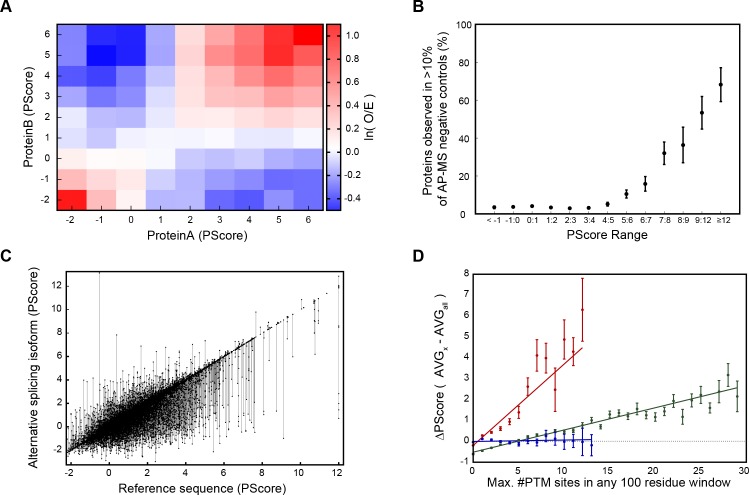
Association of phase separation propensity scores with protein interactions, splice isoforms, PTMs, and GO localization, process, and function terms.(A) Protein-protein interaction enrichment by the PScore of partner 1 vs. the PScore of partner 2. The color gradient shows the natural logarithm of the observed over expected ratio. (B) Percentage of human proteins at each PScore range that are detected in more than 10% of AP-MS negative control experiments. (C), Score ranges for alternative splicing variants shown as vertical lines sorted by reference sequence values. (D), Number of PTMs vs. average relative PScore, with methylation shown in red, phosphorylation in green, and ubiquitination in blue.